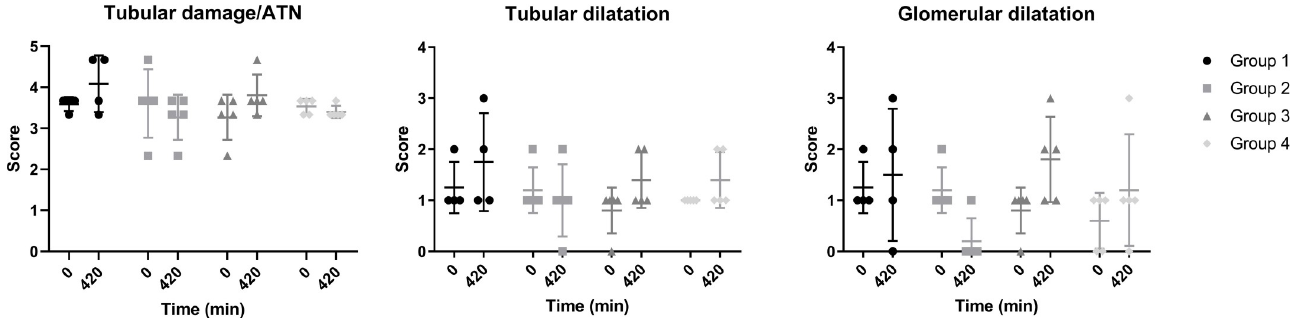
Fig 9. Scores on necrosis, tubular and glomerular dilatation at t = 0 and t = 420 (mean + SD).